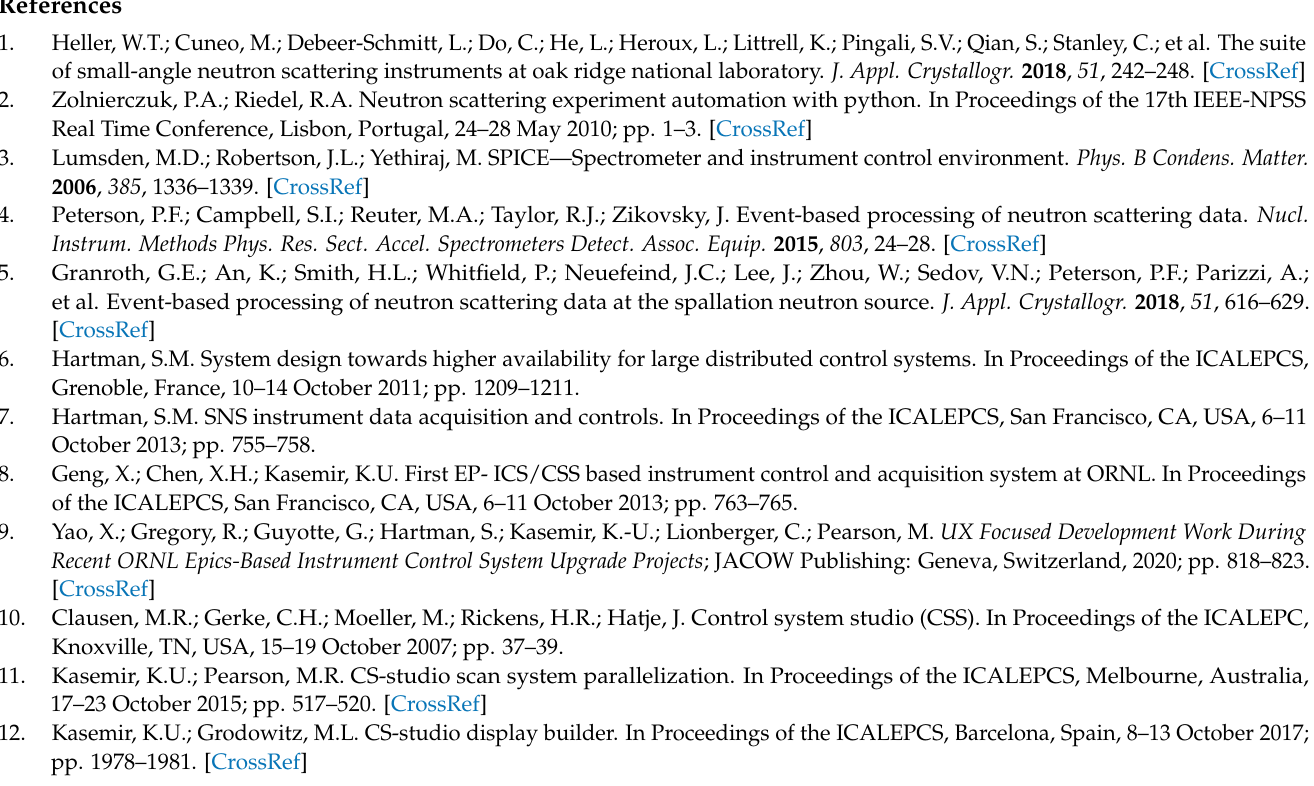
names or aliases. Figure S4: Load Samples tab in the Panel Scans interface, for more specific sample information. Figure S5: Specify Exposure Time tab in the Panel Scans interface to setup measurement time or detector count at different configurations and samples. Figure S6: Expand and Submit tab in the Panel Scans interface. It expands the scans in different ways with all conditions from previous setups (such as samples, sample environment, configurations, measurement type (transmission, scattering or both)), only part of the columns are shown in the screenshot. Figure S7: The soft matter simulator with instrument specific